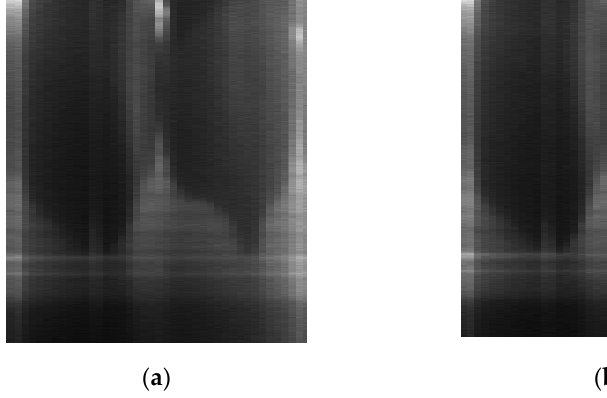
Figure 14. SDL-aided images of linden leaves at wavelengths of ( a ) 900 nm, ( b ) 970 nm, and ( c ) a water band index image of linden leaves.